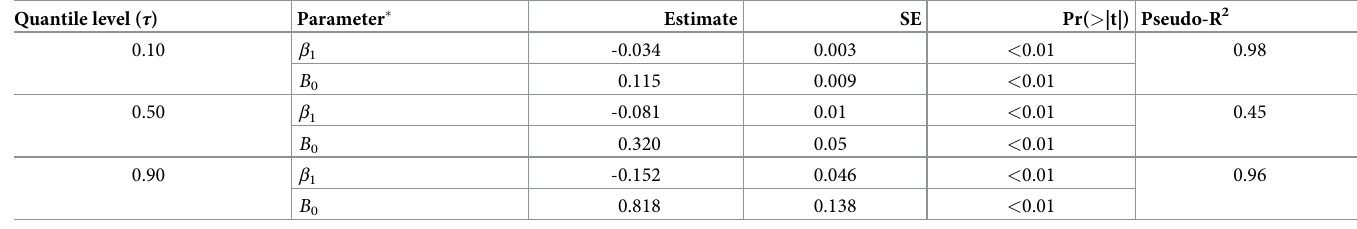
Table 3. Quantile regression estimates and goodness-of-fit statistics for the relationship between surface runoff (mm) and basal area (m 2 ha -1 ) in Molinillos, Mexico ( n = 249).